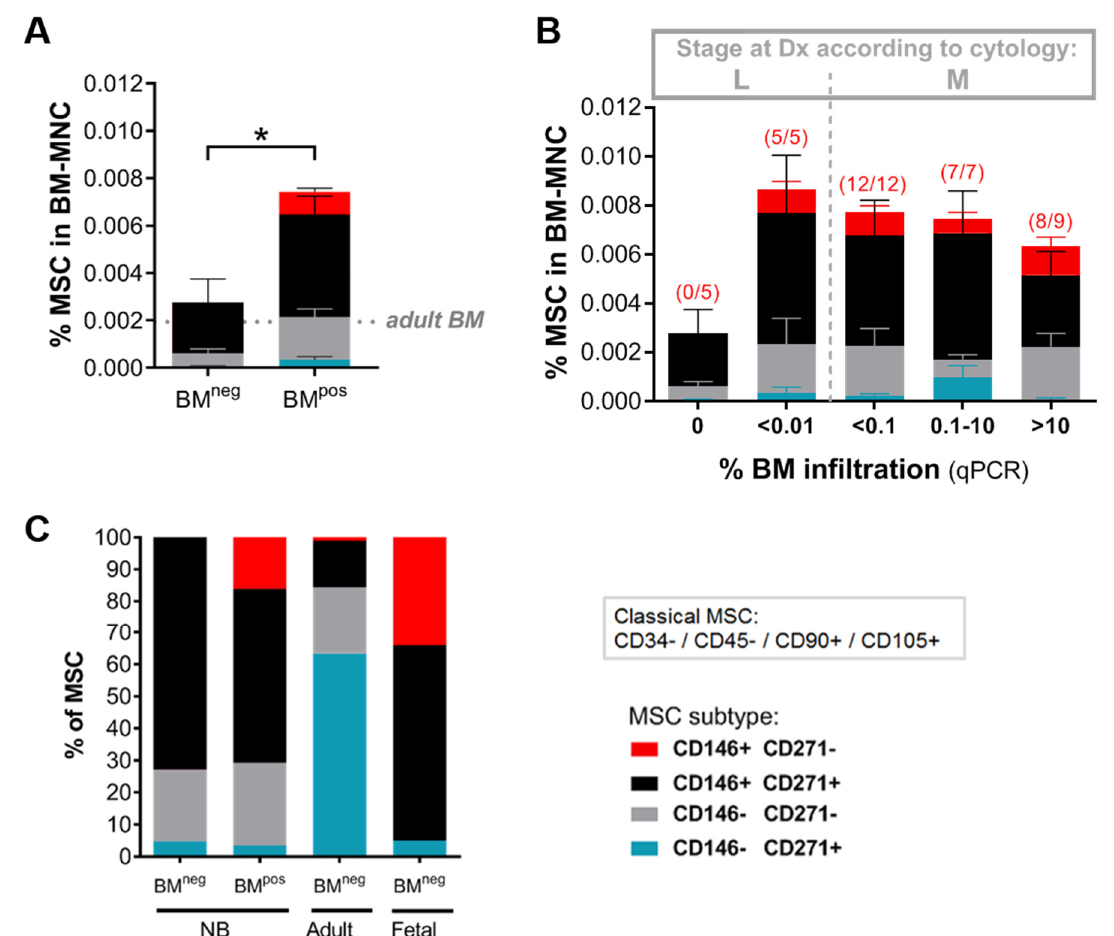
Figure 4. The metastatic BM niche contains a specific MSC subtype. Metastatic disease in the BM is defined based on qPCR positivity as BM pos and qPCR negativity as BM neg ( A ) Frequency of MSCs in diagnostic BM aspirates of patients relative to the number of BM-mononuclear cells (BM-MNC) (BM pos n = 33, BM neg n = 5). MSCs are detected by flow cytometry using the classical MSC-panel (CD34 − , 45 − , 90 + , 105 + ) and subtype distribution is analyzed based on CD146 and CD271 expression. Dotted line marks average MSC level in control adult BM ( n = 5). (*) p < 0.05. ( B ) MSC (-subtype) levels in BM samples grouped based on stage and extent of BM infiltration (as determined by qPCR). Patients were diagnosed as ‘localized’ when there was no evidence of metastases by 123 I-MIBG scintigraphy and morphological examination of BM smears / biopsies. Based on RT-qPCR results, we classified them as negative ( n = 5) or positive. qPCR positive localized BM samples ( n = 5) all contain less than 0.01% tumor cells. For stage 4 NB-patients (i.e., with metastases) the extent of BM infiltration is classified as < 0.1% ( n = 12), 0.1–10% ( n = 7), or > 10% ( n = 9). Number of BM samples positive for CD146 + CD271 − MSC is indicated in brackets above the bar. ( C ) Relative contribution of distinct MSC subtypes to the MSC compartment in diagnostic BM of NB-patients compared to fetal and adult BM. Adult MSCs: n = 4, fetal MSCs: n = 6. Data from fetal MSCs is adapted from Maijenburg et al., 2012 [36].